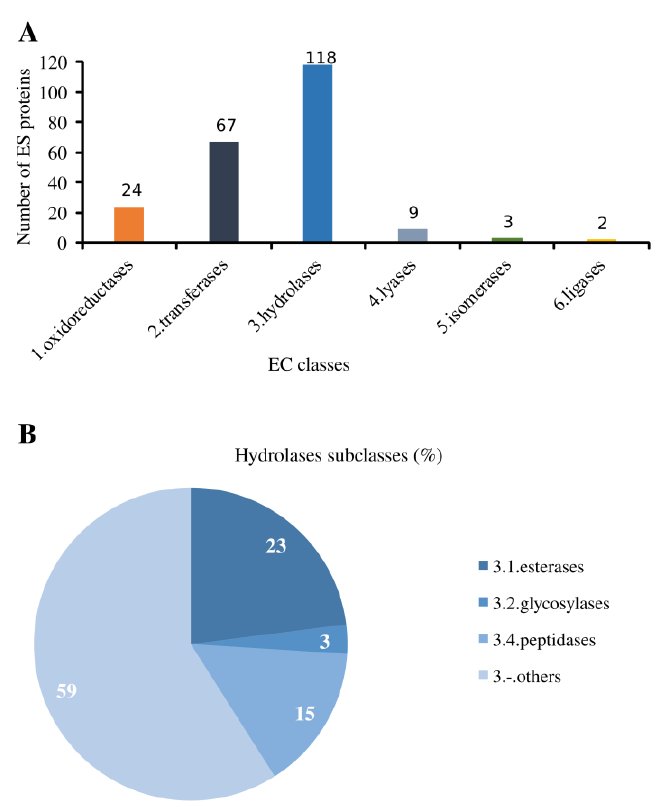
Figure 2. ES proteins of R. viridisi with enzymatic function predicted by ECPred: ( A ) Enzyme Commission (EC) classes, and ( B ) subclasses of hydrolases.